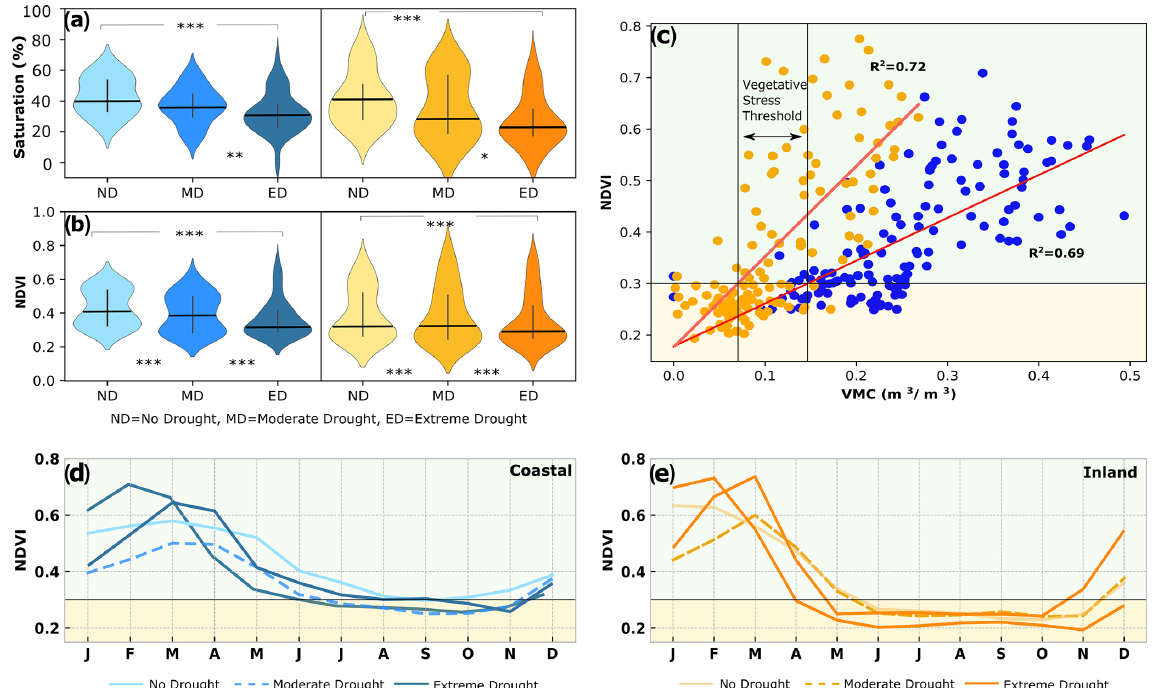
Figure 6. (a) Monthly average saturation of soil moisture and (b) daily mid-month NDVI during non-drought, moderate, and extreme drought periods at the coastal (blue) and inland (orange) sites. Medians are indicated as black horizontal lines. Significance levels are indicated at p < 0 . 001 ( ∗∗∗ ), 0.01 ( ∗∗ ), and 0.05 ( ∗ ). (c) Regression of monthly average soil moisture and NDVI ( R 2 = 0 . 69 coastal, R 2 = 0 . 72 inland) to establish a vegetative stress threshold, below which vegetation is most likely senescent. (d, e) Annual dynamics of NDVI during years of non-drought, moderate, and extreme drought years illustrate the shift in green-up (start of consistent NDVI increase following winter rains). Extreme drought (ED) years show maximum NDVI values early in the year, with a rapid decline in greenness